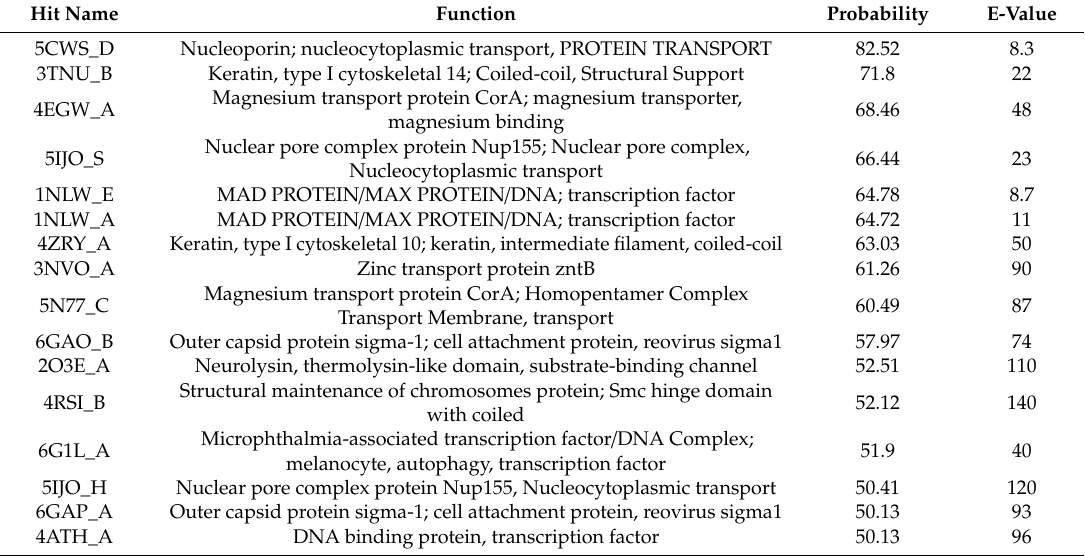
Table 1. Predicted function of protein Open Reading Frame I (ORF